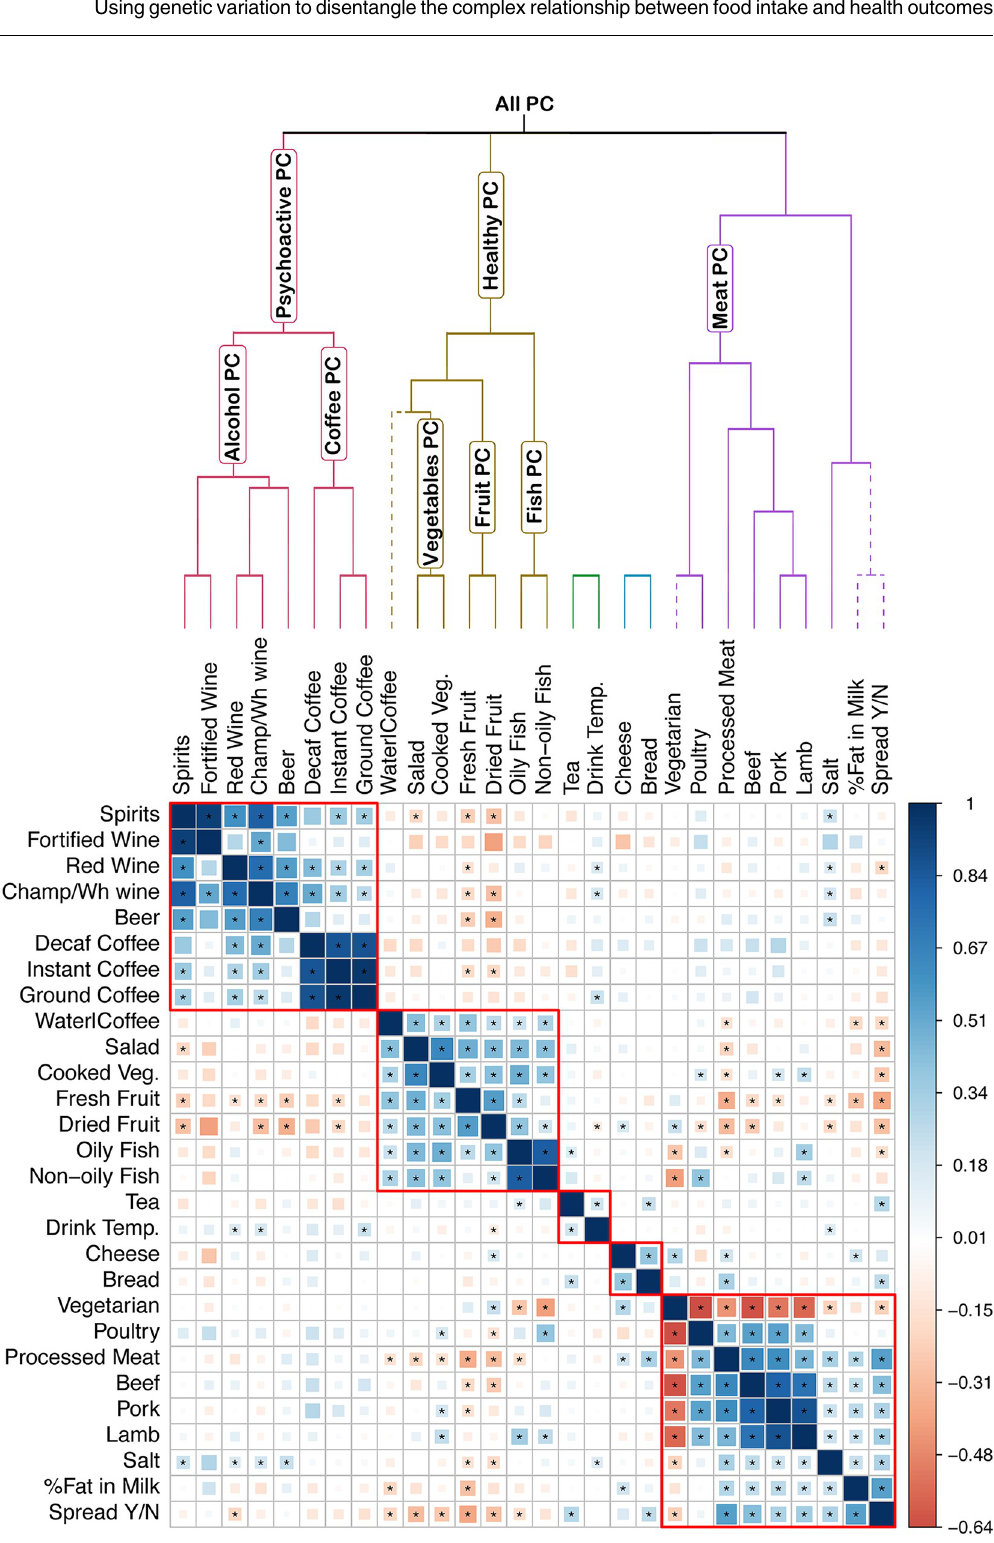
Fig 3. Clustering of the food traits and definition of measures of dietary patterns. The plot reports the genetic correlation plot amongst the food traits after applying the correction. The stars report the Bonferroni-corrected significant correlations. The dendrogram and the boxes represent the clustering according to the ICLUST algorithm. The labels on the dendrogram branches show the traits used to define each measure of dietary pattern. The dashed line represents the traits excluded from the estimation of the dietary pattern traits. The “Vegetarian” trait was excluded from the “Meat PC” trait but was included in the overall dietary pattern measure (All PC).